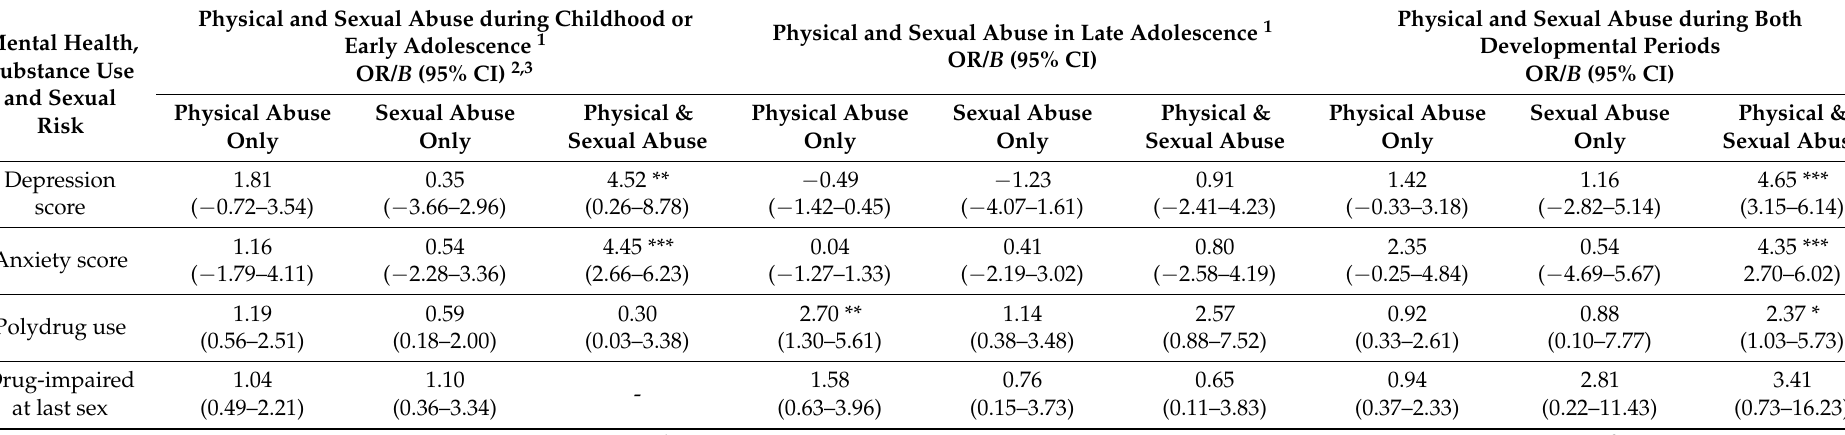
Table 4. Associations between type of abuse, developmental period of exposure, and risk of common mental disorders among young women who use substances in Cape Town, South Africa ( n = 499) 1